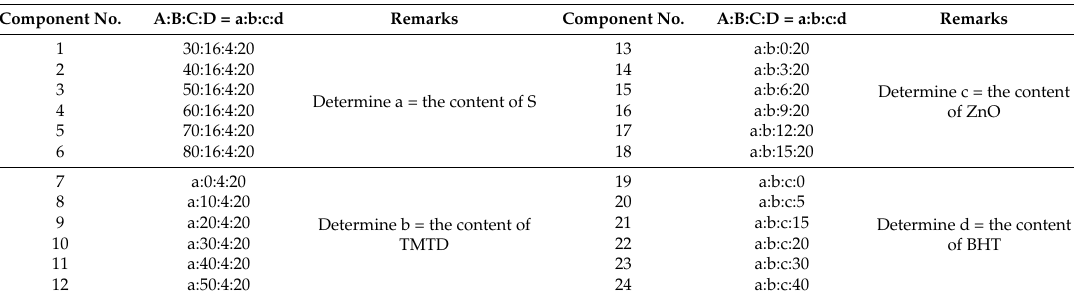
Table 1. Stabilizer component test design.